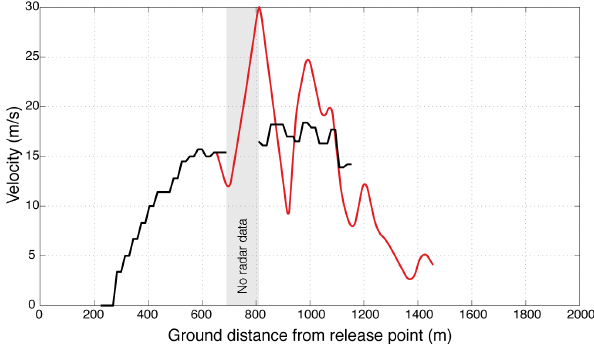
Figure 6. Comparison of avalanche front velocity as measured by the radar (black line) and derived from infrasound array analysis (red line). Gray bar show the velocity of different sectors of the avalanche path derived from infrasound